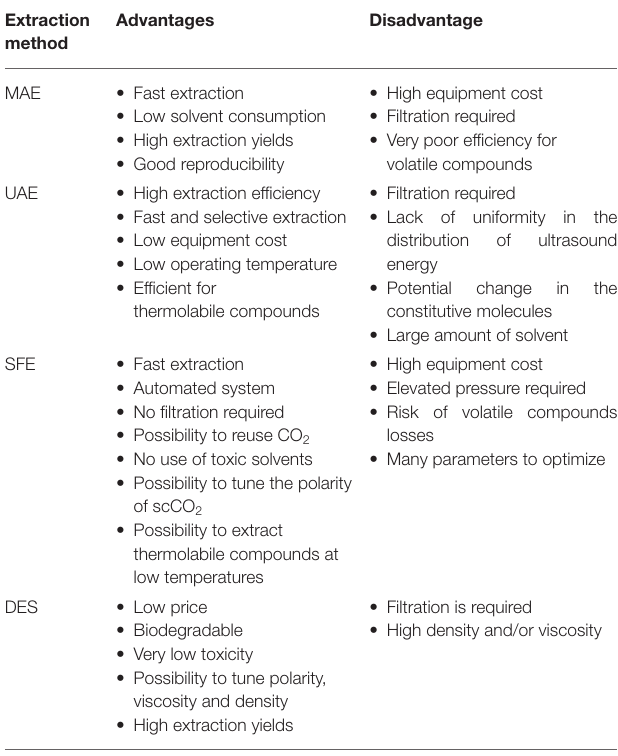
TABLE 4 | Main advantages and disadvantages of the extraction techniques reviewed in this paper. Extraction